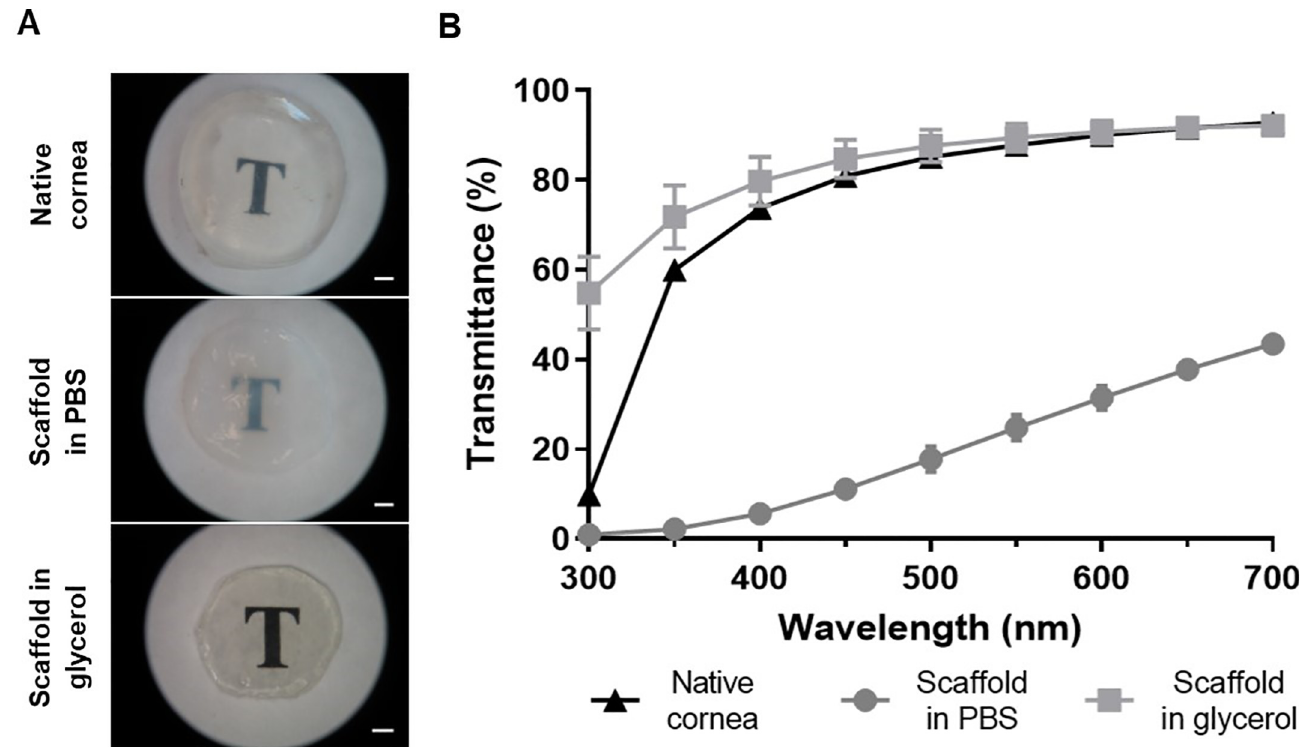
Fig 2. Scaffold optical clarity and light transmission. A) Macroscopic optical clarity. Scale bar = 1 mm. B) Light transmittance spectra.